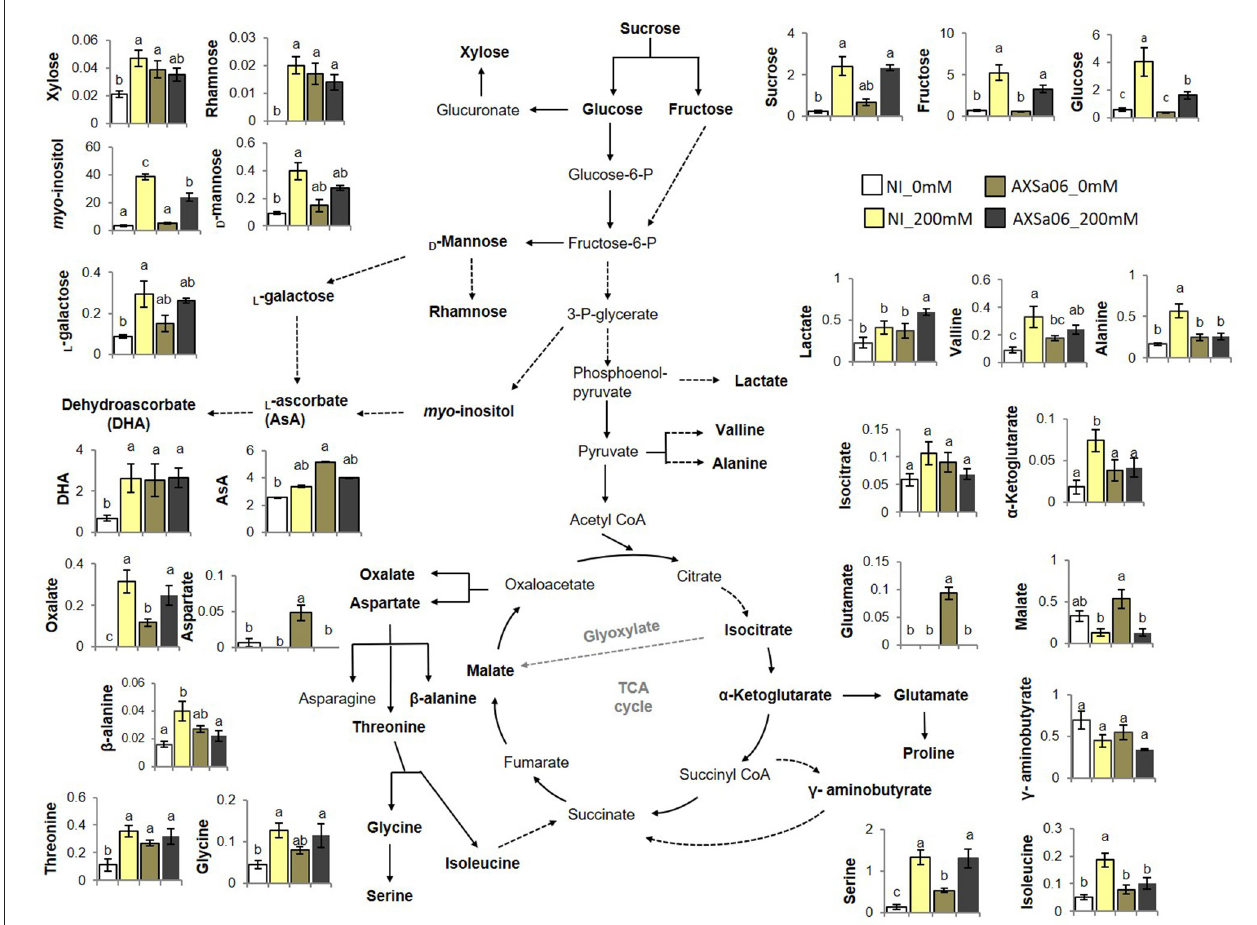
FIGURE 6 | Selected metabolomic profiles of leaves from tomato seedlings inoculated or not with AXSa06 ( Pseudomonas oryzihabitans ) at exposure to 200mM NaCl. Amounts were expressed as relative abundance based on the relative response compared to internal standard adonitol and are provided in Supplementary Table 12 . Ascorbic acid (AsA) and its oxidized form (dehydroascorbate, DHA) were determined spectrophotometrically based on the AO enzyme method. Data are means of five biological replicates ± standard error. Different letters indicate statistically significant differences between treatments based on Duncan’s multiple range test ( P < 0.05). NI,